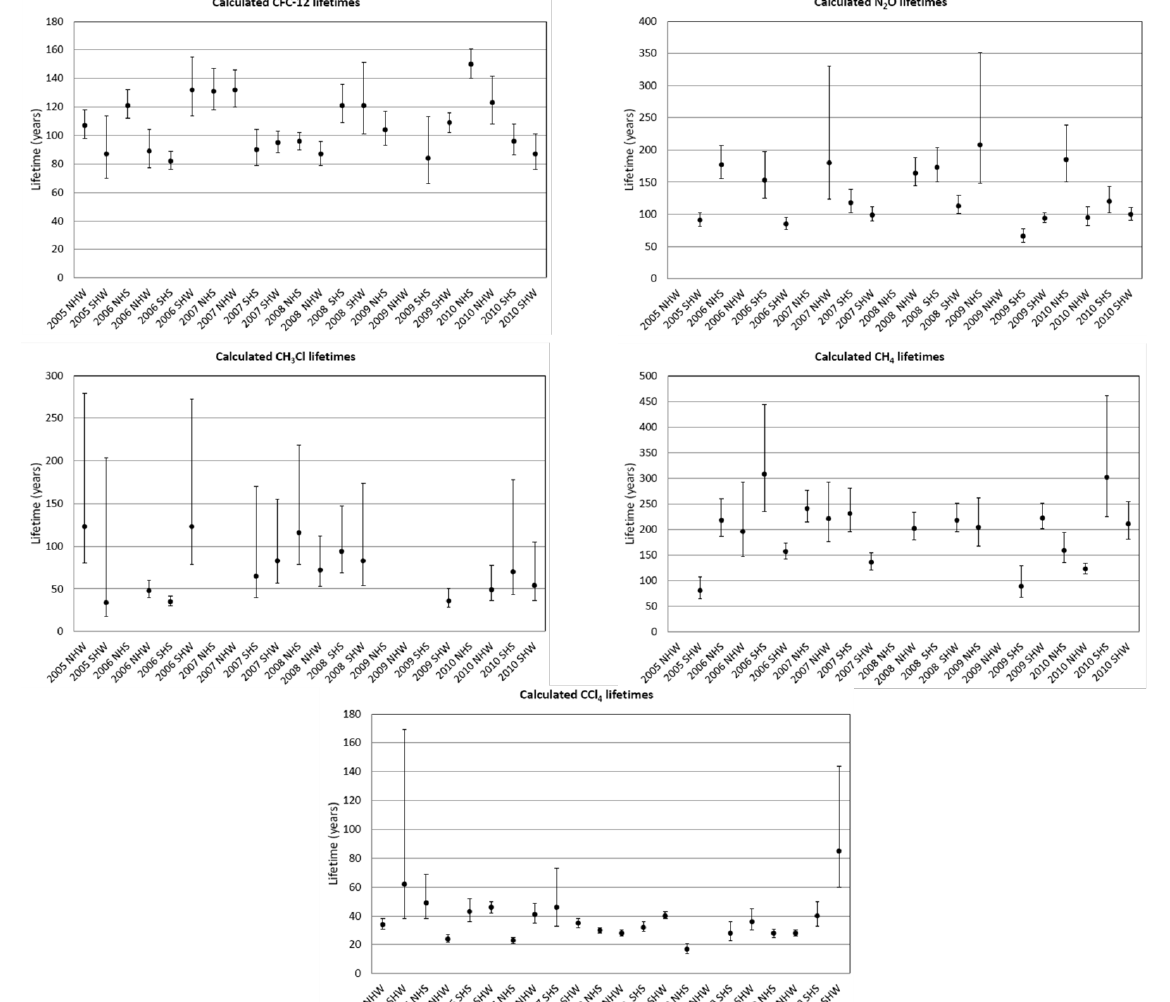
Figure A3 A graphical representation of the lifetimes of CFC-12, CCl 4 , CH 3 Cl, N 2 O and CH 4 calculated using a CFC-11 of 50 years. The data is presented in the same order as it appears in the main paper